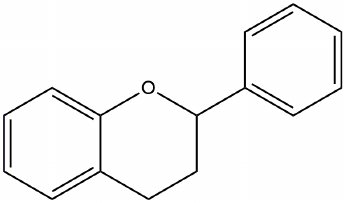
Figure 1. The basic skeleton of flavonoids.